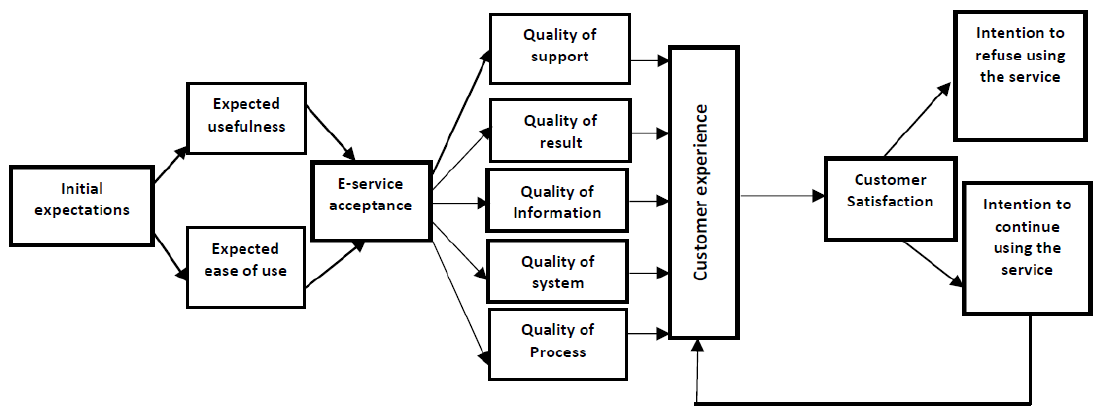
Figure 2. Integrated e-service adoption–continuance quality model.